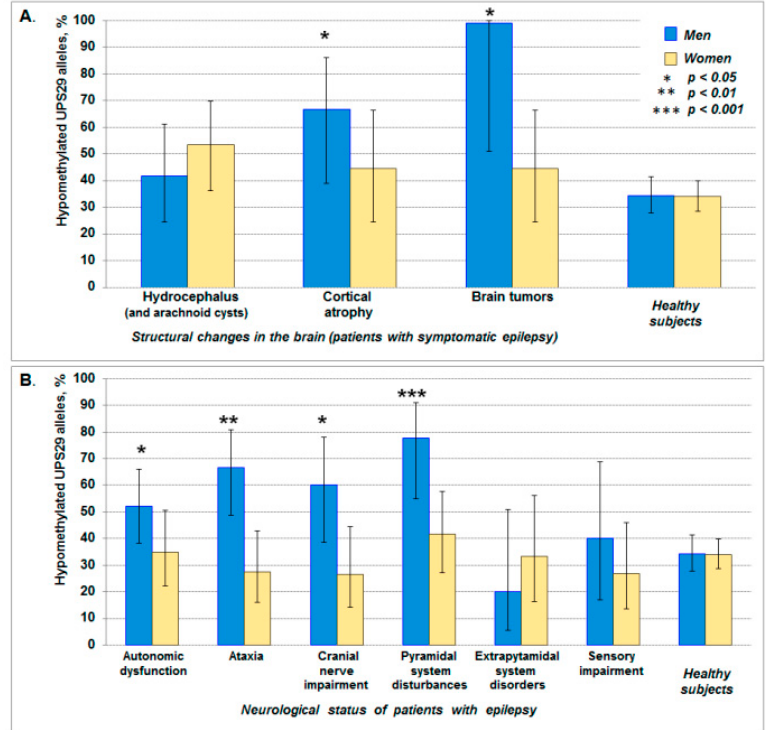
Figure 4. The frequency of hypomethylated (unmethylated) UPS29 alleles in patients with epilepsy with di ff erent structural changes in the brain ( A ) and neurological status ( B ). The data is shown with 95% CI. The asterisk indicates statistically significant di ff erences in comparison with control (healthy